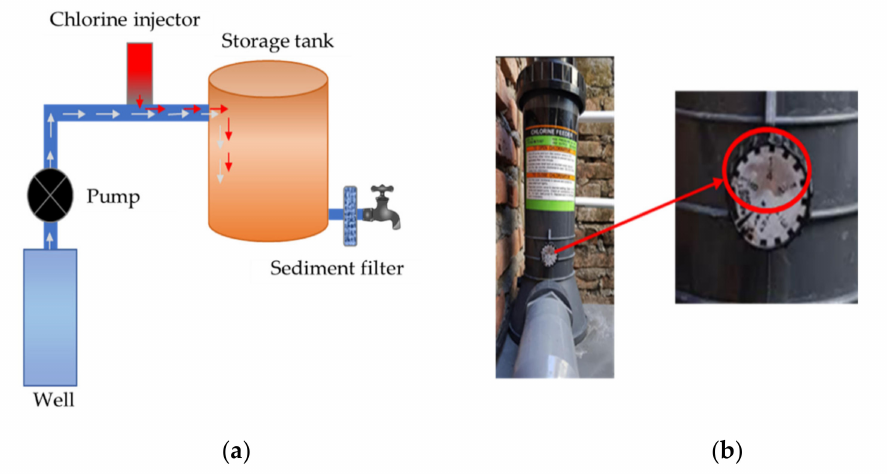
Figure 4. ( a ) Installation of chlorination system; ( b ) chlorine injector and controlling